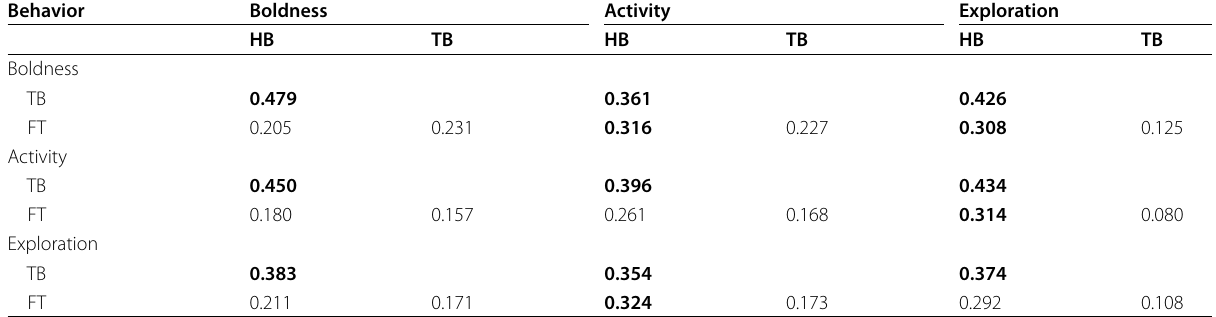
Table 5 Correlations of different behavioral categories in PCA scores across different test contexts. Boldness, activity, and exploration assessed across hole-board box (HB) and tunnel-box (TB) tests were consistently more correlated to one another ( r > 0.35) than between flight-tent (FT) tests with either HB or TB tests ( r < 0.35 or